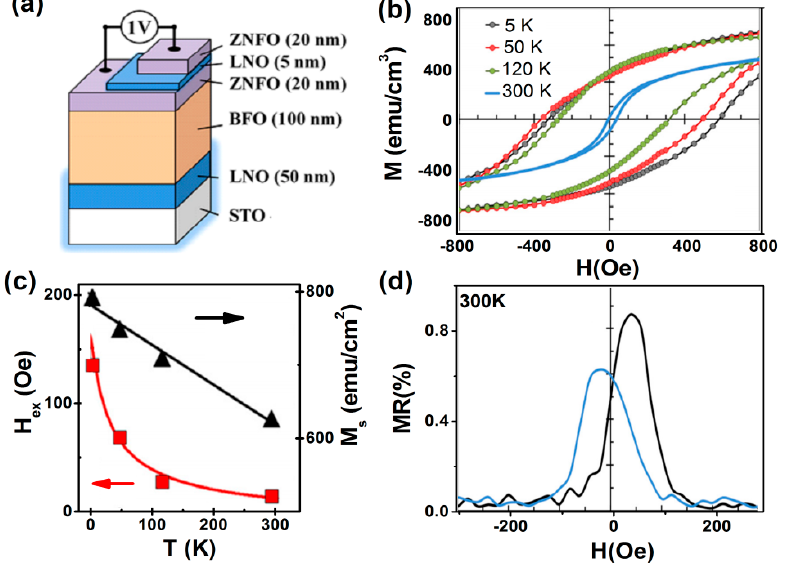
Figure 11. ( a ) Schematic of spin valve with the ferroelectric anti-ferromagnet BFO as the pinning layer and the proposed materials for other epitaxial layers. ( b ) M-H loops recorded upon heating up. The sample was annealed at H ann = 3 kOe from 400 °C to room temperature before the measurements. The arrow indicates the direction of H ann . ( c ) Temperature dependence of the exchange bias ( H ex ) and saturation magnetization ( M s). ( d ) The MR measured in such a spin valve heterostructures (Reproduced with permission from [64]. Copyright Elsevier, 2013).